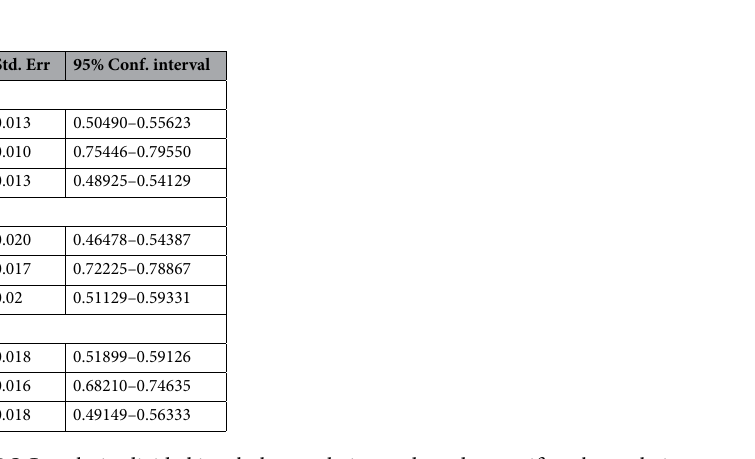
Table 2. Overview of ROC analysis, divided in whole population and gender specific subpopulation.